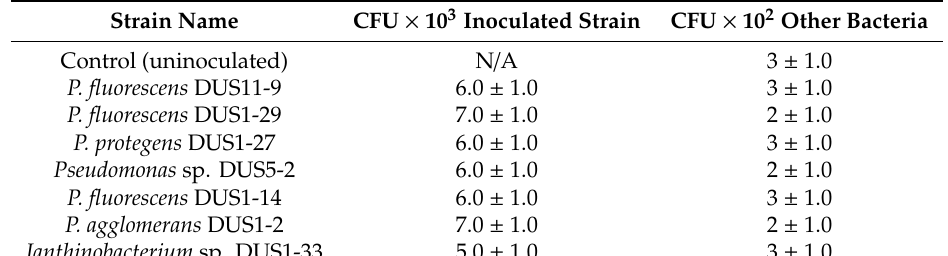
Table 3. Colony forming units of inoculated bacteria per g of sand-based medium and CFU per g of “other bacteria” associated with canola grown in sterilised sand-based medium for 30 days with media (soil) maintained at 1.5% water activity. For each strain, 1 mL of cells (1 × 10 3 ) was applied to seedlings five days post germination. No significant difference ( p < 0.05) was observed for CFU of inoculated strains or “other bacteria” in the sand-based medium after 30 days.